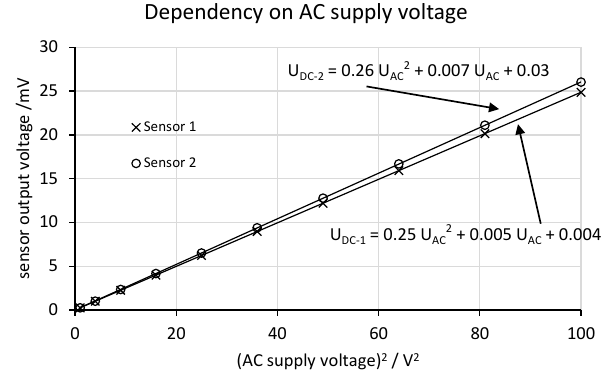
Figure 5. AC supply voltage dependence of the sensor signal in a room environment. The lines represent polynomial fits of the third order with no constraints. It can be seen that, within the range of supply voltages, the quadratic term is 370–500 times greater than any other term, indicating that the measured signal represents a DC thermovoltage generated by ohmic heating of alternating currents through the thermopile. The power applied to the sensor calculates as P = U 2 /R . Since R = 120k (cid:127) , the maximum power is 0.83mW.